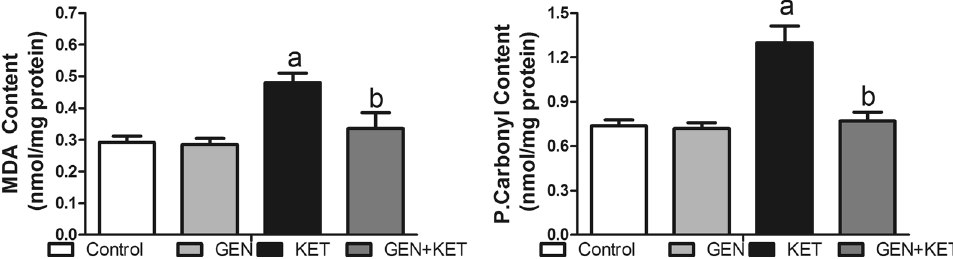
Fig. 2 Effect of GEN on hepatic MDA and P. Carbonyl contents in control and KET-treated rats. Each column represents the mean in each group. Significance was determined by one-way analysis of variance followed by a Dunnett’s t test: a P < 0.05 versus control group; b P < 0.05 versus